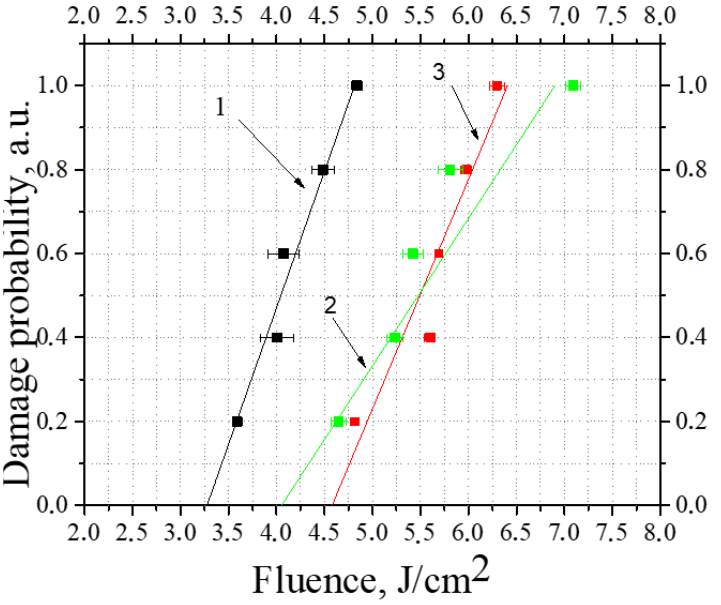
Figure 4. Damage probability vs the laser beam fluence for the original ZnSe samples from different manufacturers: the polycrystalline ZnSe manufactured by INOPTICS, Nizhny Novgorod, Russia (1); the polycrystalline ZnSe manufactured by PromLab LLC, Nizhny Novgorod, Russia (2); the polycrystalline ZnSe manufactured by II-VI Incorporated, Saxonburg, USA (3). The PRR of the Ho 3+ :YAG laser was 12 kHz, the exposure duration was 1 s.